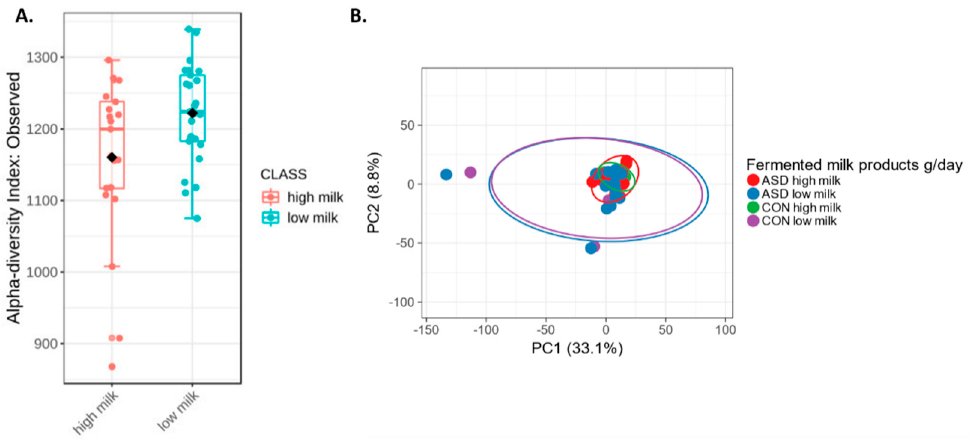
Figure 9. Alpha-diversity ( A ) and beta-diversity ( B ) of intestinal microbiota in children with high and low daily intake of fermented milk products.